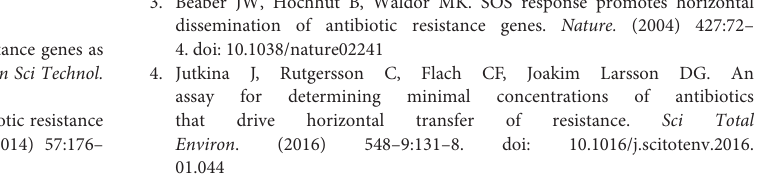
Supplementary Figure S1 | Number and distribution of shared resistance genes detected during GP processing. Supplementary Figure S2 | Heatmap of the relative abundance of ARGs during GP processing. The color transition from dark blue to dark red represents the relative abundance from low to high. Supplementary Figure S3 | (Left) Venn diagram for each out to compare the richness shared among three groups. (Right) PCA based on the Bray–Curtis distance showing the overall distribution pattern of bacterial communities during GP processing. Supplementary Figure S4 | Network analysis revealing the co-occurrence pattern among bacterial communities in GC, GS, and GP samples. The nodes were colored according to the bacterial phyla. A connection represents a strong (Spearman’s correlation coefficient r > 0.90) and significant ( p < 0.01) correlation. Edges and node size weighted were based on the correlation coefficient and the relative abundance of bacteria, respectively. The edge colors represent positive correlation (red) and negative correlation